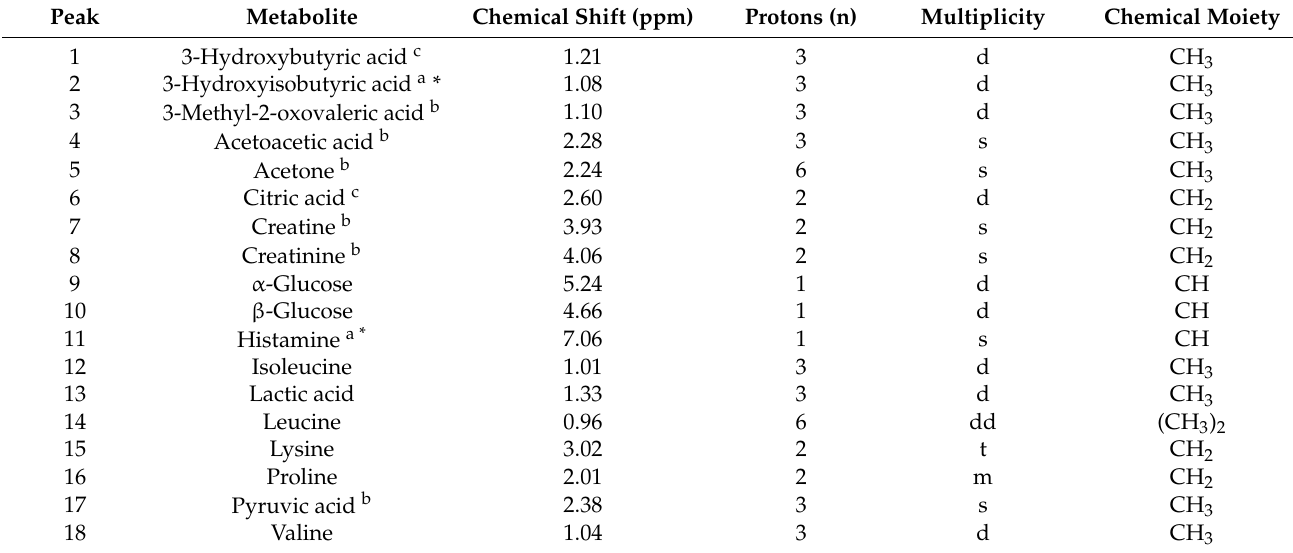
Table 3. 1 H-NMR assignments of identified